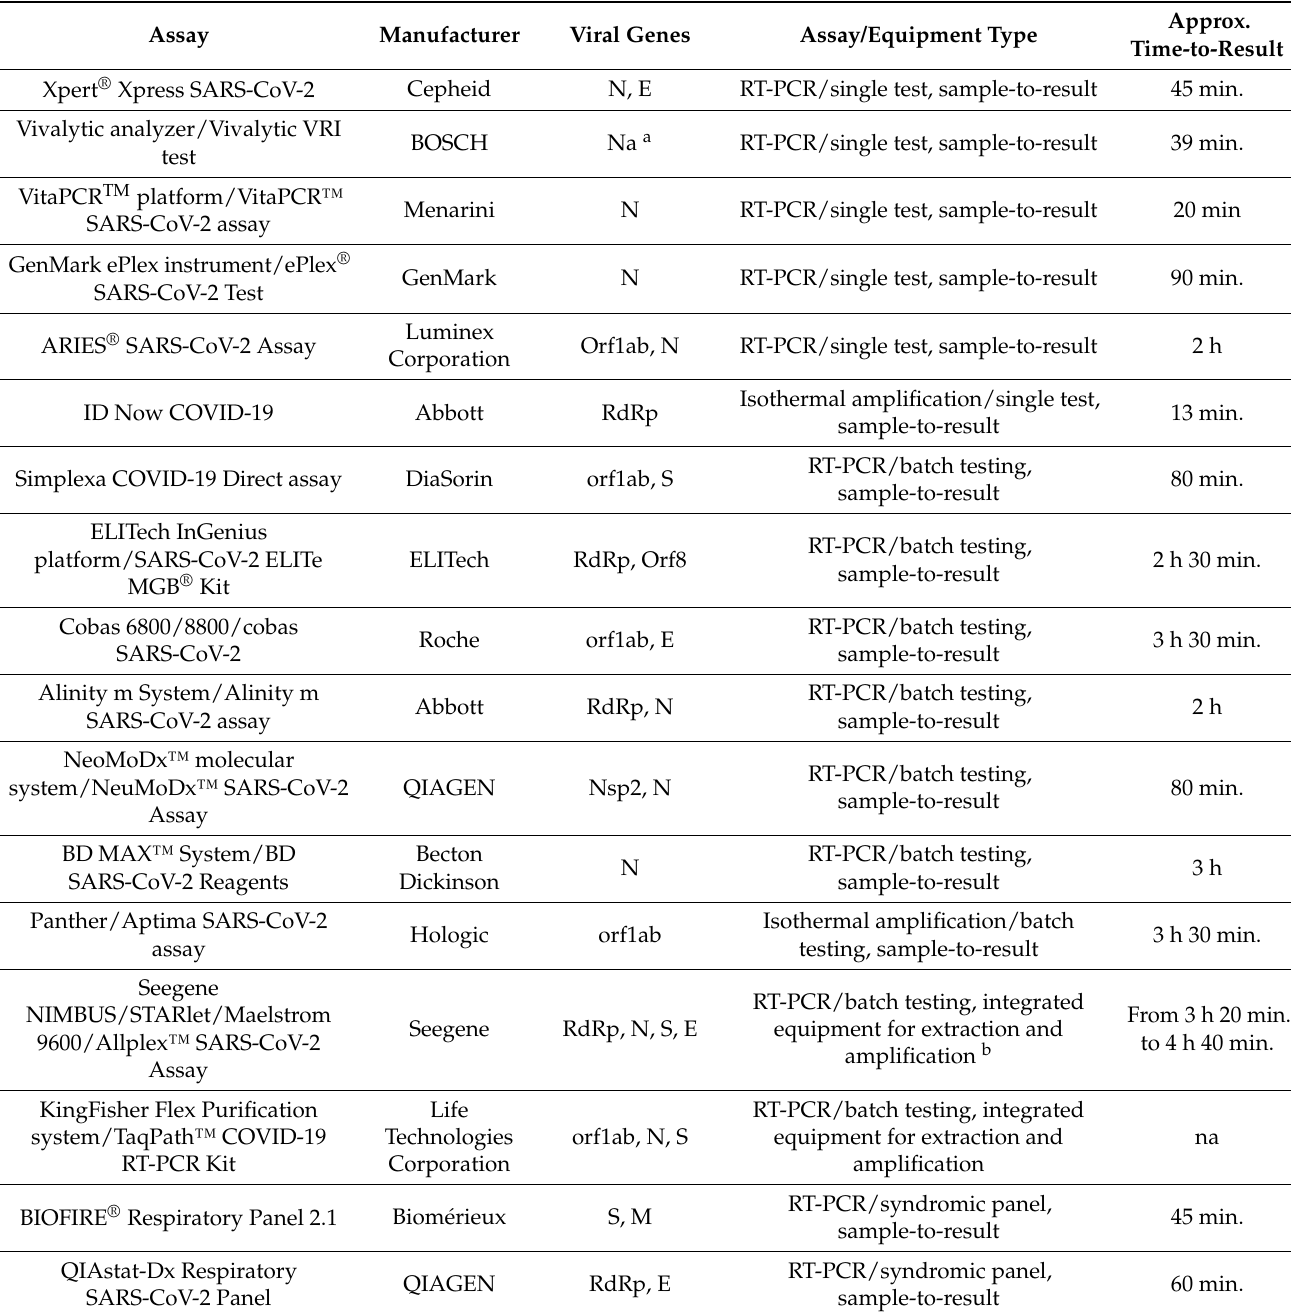
Table 3. The main CE-IVD and/or emergency use authorization (EUA)-labelled integrated extraction/amplification platforms and sample-to-result assays for the detection of SARS-CoV-2. Assay Manufacturer Viral Genes Assay/Equipment Type